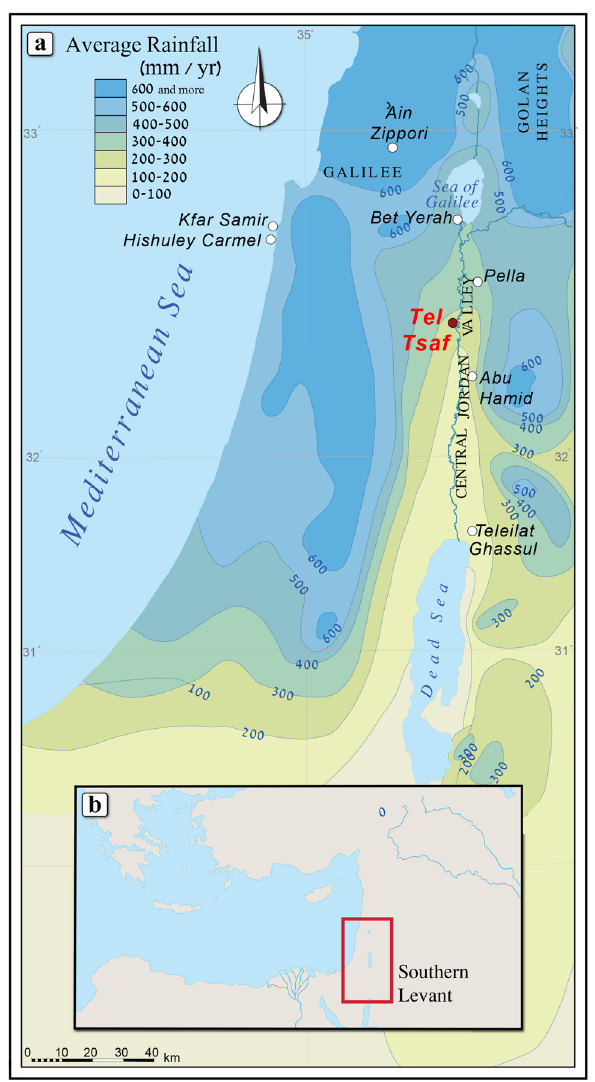
Figure 1. ( a ) Map of the southern Levant indicating mean annual precipitation in mm 25 ; ( b ) the position of the southern